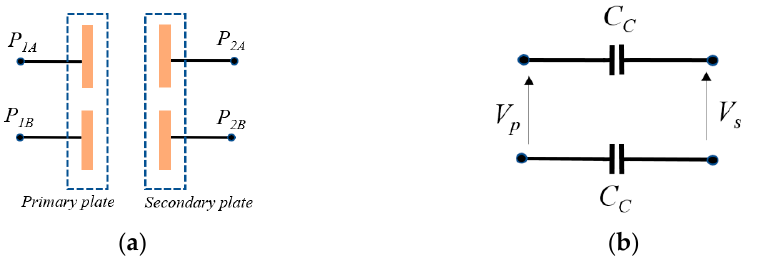
Figure 1. Plate structure. ( a ) Four-plate structure, ( b ) normal capacitive coupling model. The four-plate structure has been analyzed in various capacitive coupling models.